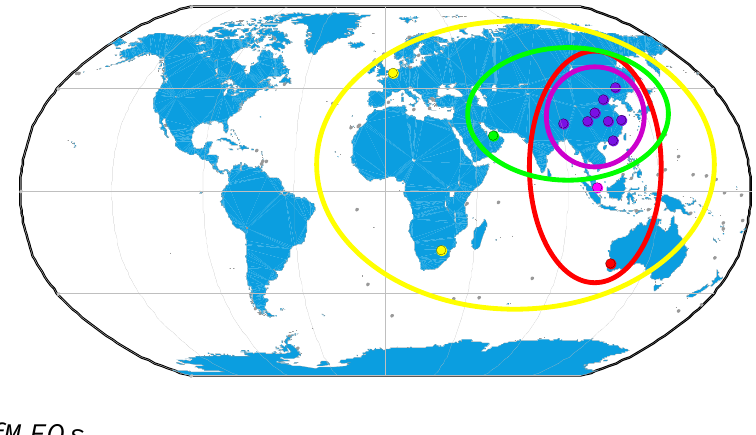
Figure 5. Tracking networks defined for the impact study of tracking geometry on satellite orbits. The Chinese regional network is indicated by a violet cycle, Asian-Pacific network in red, Asian network in green, and global network in